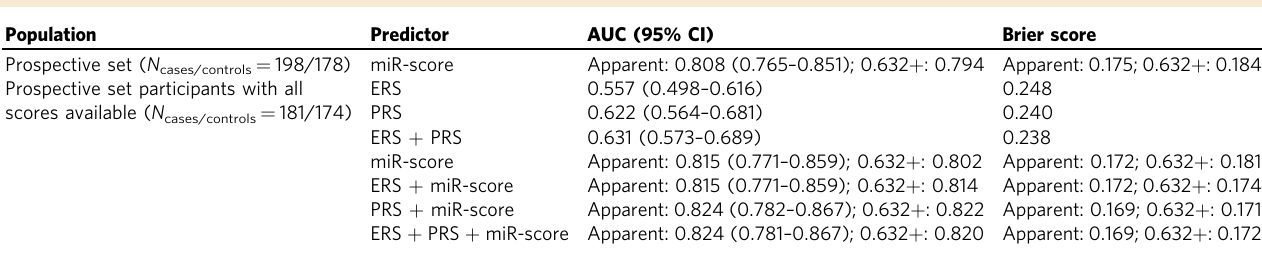
Table 3 Risk prediction by individual and combined risk scores for